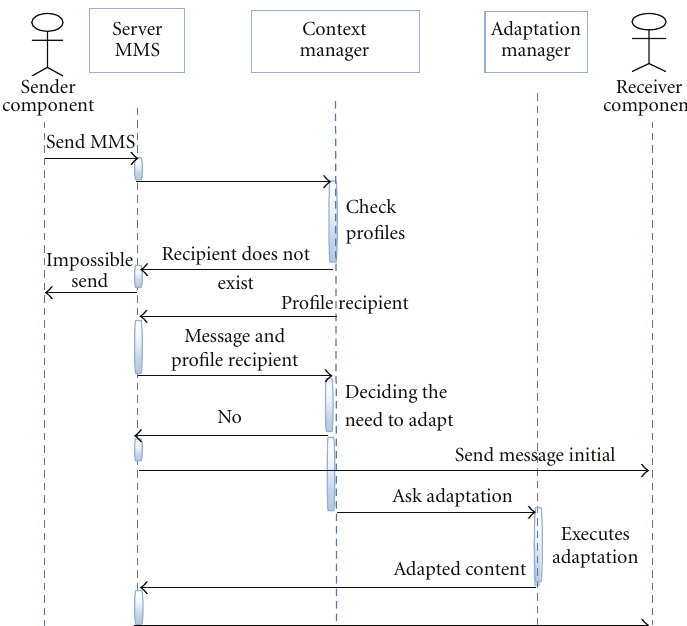
Figure 23: Sequence diagram.